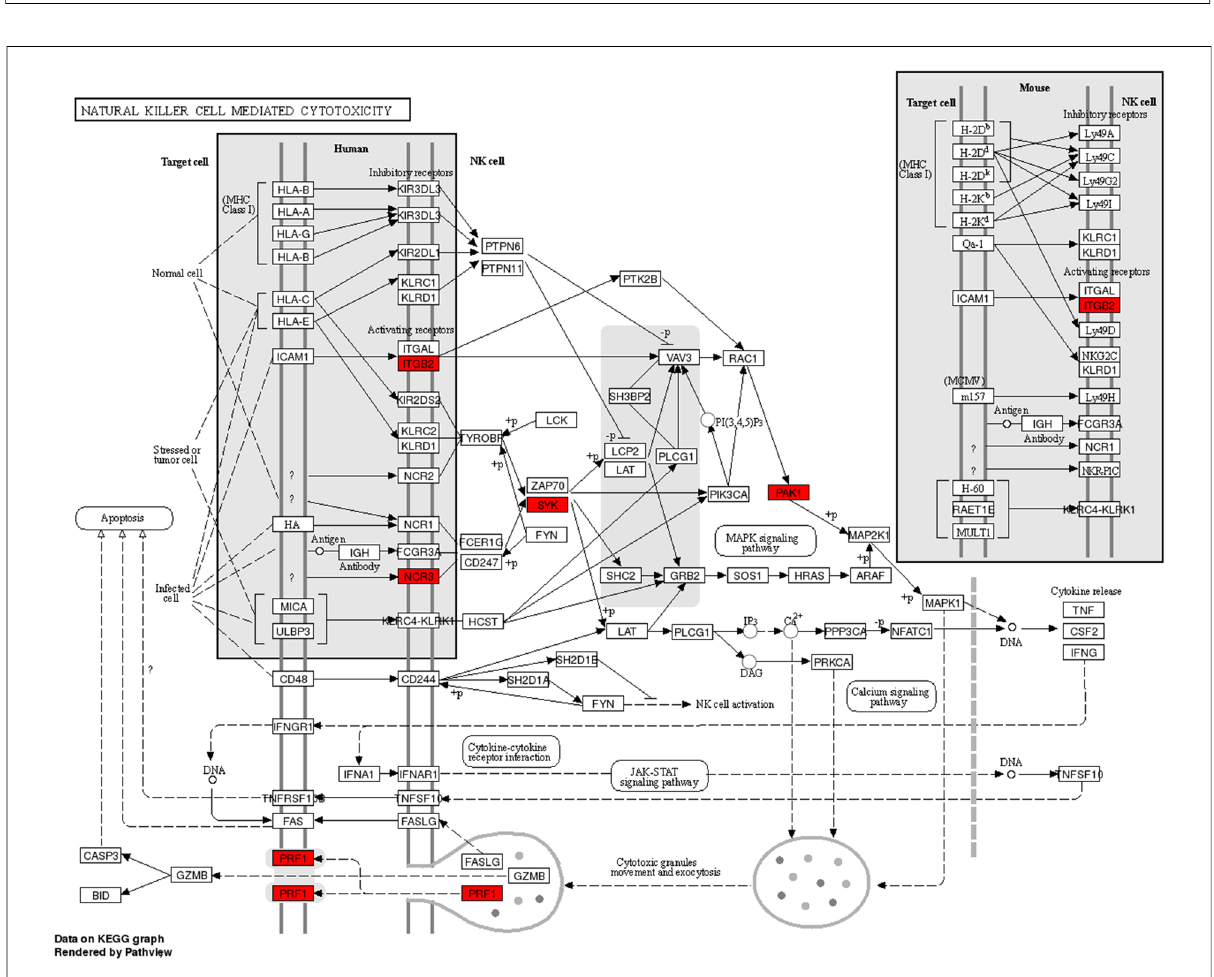
FIGURE 6 The natural killer cell-mediated cytotoxicity